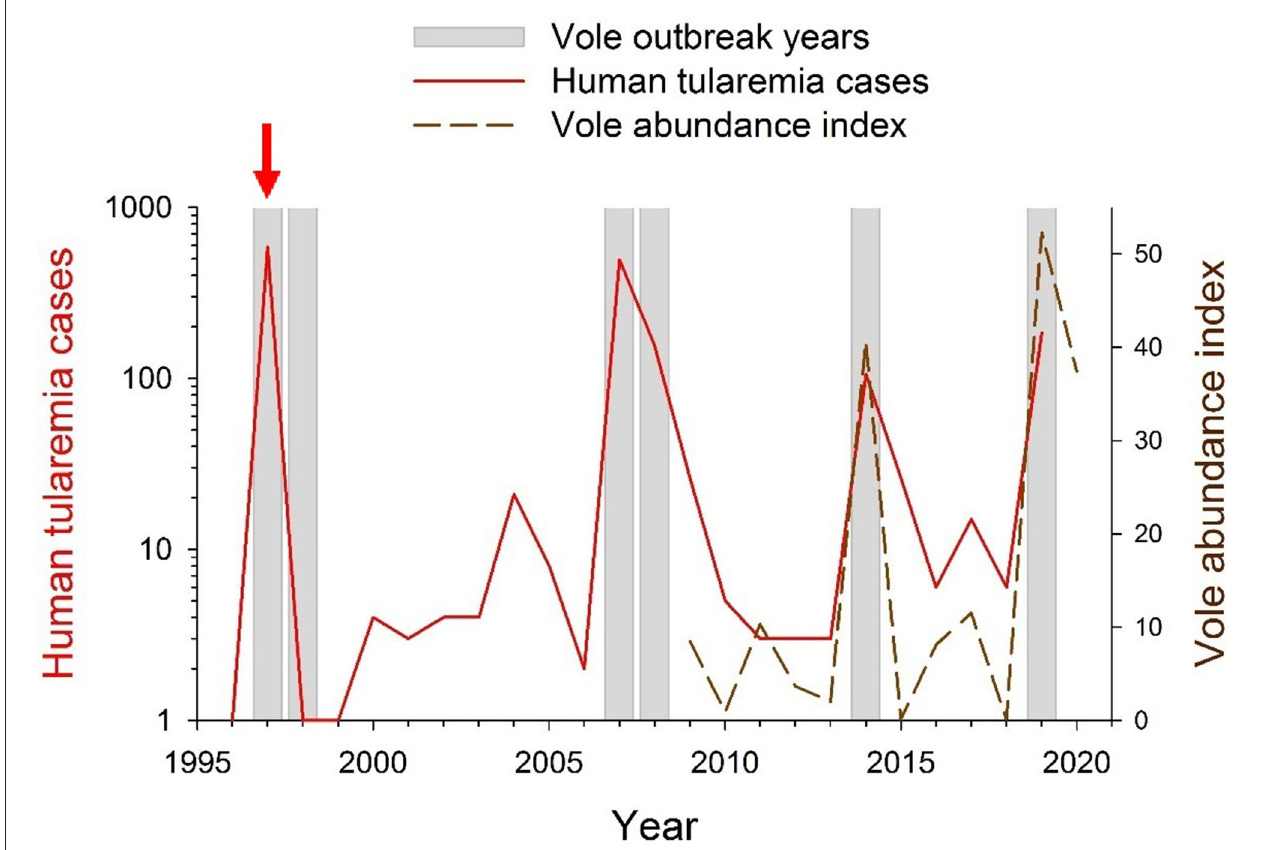
FIGURE 2 | Yearly occurrence of vole and tularemia outbreaks in NW Spain between 1996 and 2020. During 1996–2008, vole outbreak years were identified by Luque-Larena et al. (45). During 2008–2020 vole outbreak years were identified based on common vole abundance indices obtained from live-trapping monitoring [( 45, 48, 49), and unpublished data]. Data on yearly numbers of human tularemia cases (in red; log-transformed) were obtained from the Red Nacional de Vigilancia Epidemiológica (RENAVE; Instituto de Salud Carlos III, Madrid, Spain). The red vertical arrow indicates the year 1997, when tularemia became a notifiable disease in